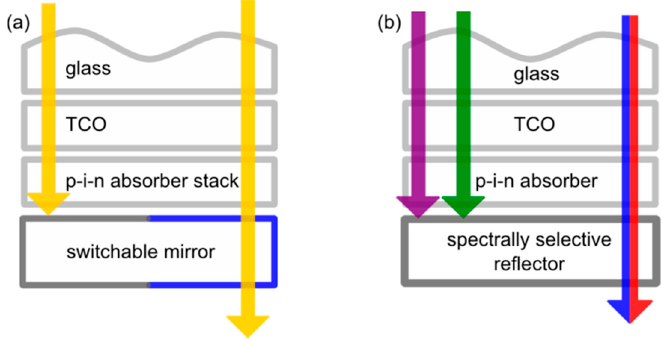
Figure 5. Illustration of a switchable solar cell ( a ) and a spectrally selective solar cell ( b ).